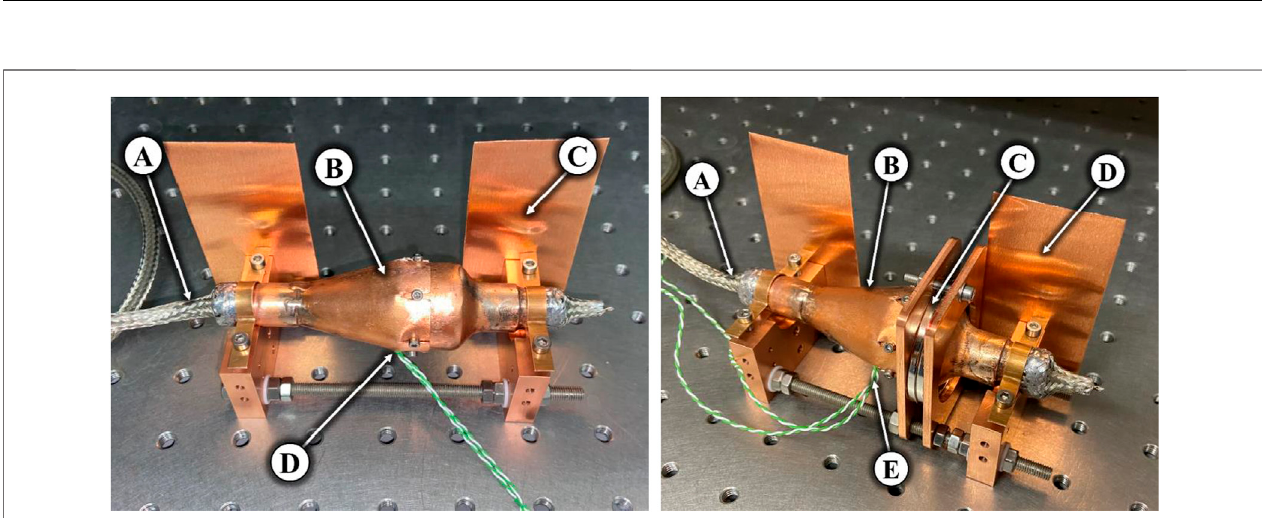
FIGURE13| YBCOBulk Setup.Left:Manufacturedsetup withtheYBCO bulkinside atapered copper housingclamped tothe copper mount and thermocouples attached to the superconductor. (A) Coaxial wire connection; (B) Copper housing; (C) Copper fi ns; (D) Thermocouple outlet. Right: Enhanced YBCO setup with two axially magnetised neodymium 30UH permanent magnet rings positioned coaxially to the superconductor. (A) Coaxial wire connection; (B) Copper housing; (C) Permanent magnet rings; (D) Copper fi ns; (E) Thermocouple outlet.